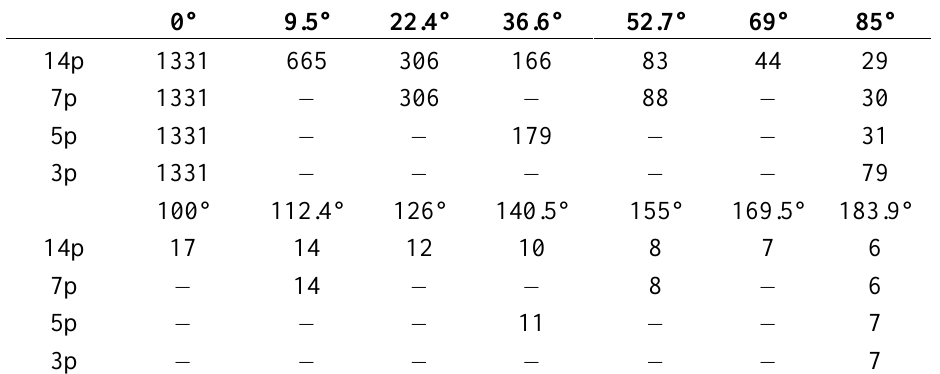
Table 3. Shrinking processes of the search space from different